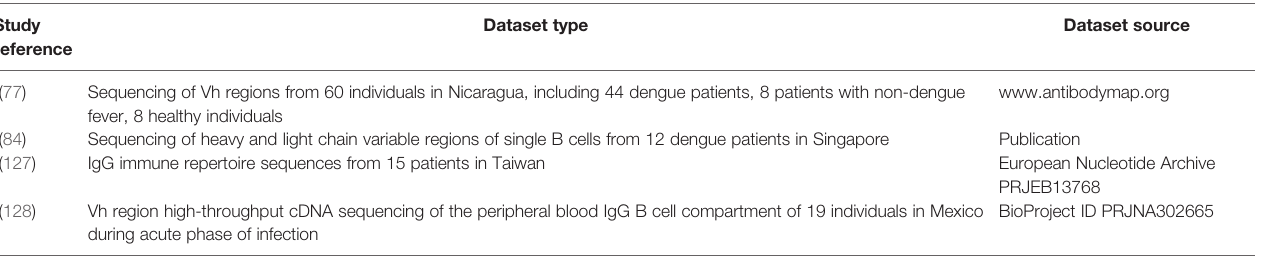
TABLE 4 | Dengue immune repertoire